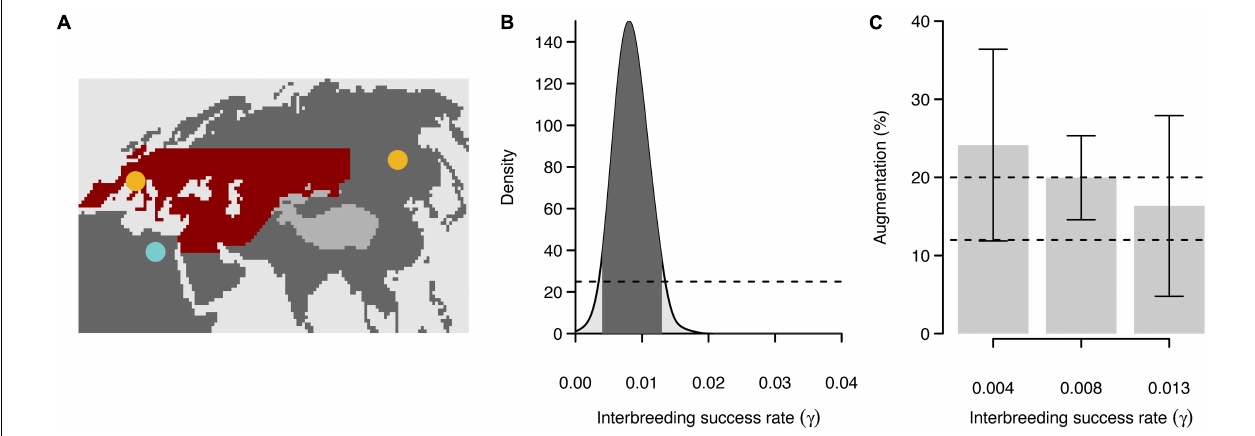
FIGURE 5 | Case study on hybridization between Neanderthals and modern humans. (A) Simulated framework used in our analysis. The red area denotes the range occupied by Neanderthals. The sky-blue dot represents the starting area of modern human range expansion [chosen arbitrarily in east Africa, see Currat and Excoffier (2011)]. The two yellow dots are sampling locations where the amount of introgression is estimated. (B) Estimated value of the interbreeding rate between Neanderthals and modern humans estimated through an approximate Bayesian computation approach. The dotted line denotes the prior distribution of explored values. (C) Estimated augmentation of introgression in East Asia compared to Europe by using the most likely value of interbreeding rate (minimum and maximum bonds as well as mode). The average augmentation of simulated values is presented with a 95% confidence interval. The dotted lines delimit the range of observed augmentation values